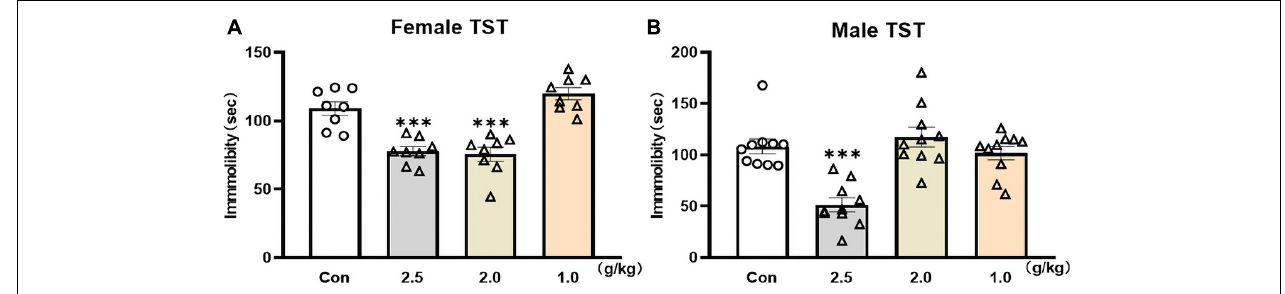
FIGURE 1 | Fast screen of potential rapid antidepressant-like effect of YG in TST of male and female mice. (A) Immobility time was measured for the last 4 min during the total 6-min testing time in female mice after different dosages of YG treatments (1.0, 2.0, and 2.5 g/kg). (B) Immobility time was measured for the last 4 min during the total 6-min testing time in male mice after different dosages of YG treatments (1.0, 2.0, and 2.5 g/kg). Independent mouse was used to test the behaviors at each time point. ∗∗∗ p < 0.001, compared with the control group, one-way ANOVA, n = 8–10/group.